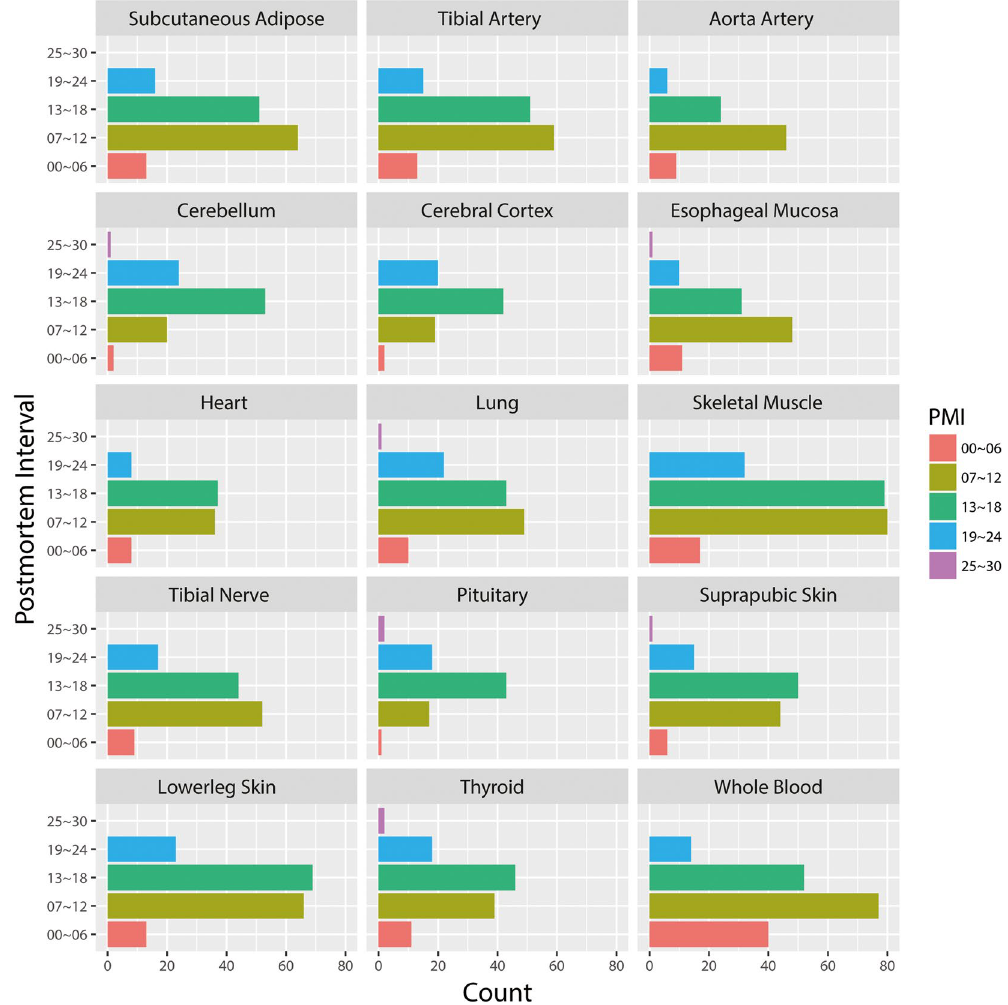
Figure 1. Postmortem Interval distribution of samples in 15 human tissues. Each histogram denotes the distribution of samples with different PMIs in